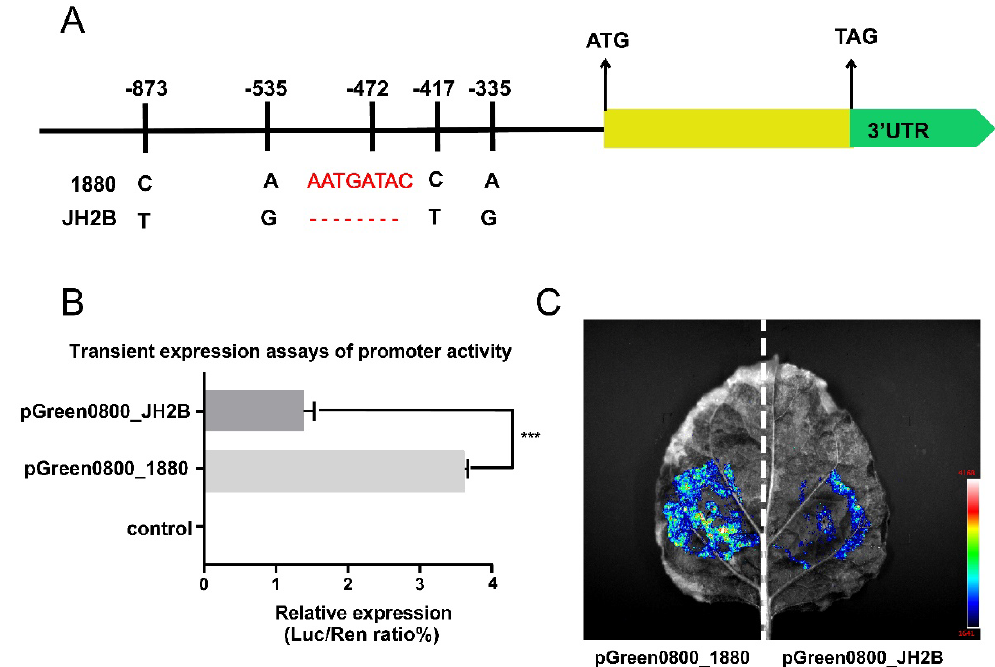
Figure 5. Sequence variations in the OsHd8 promoter. ( A ) Schematic representation of the two major variations of the OsHd8 promoter region. CT repeats are labeled in blue; red represents an InDel; ( B ) Transient expression assays of the two OsHd8 promoter types in rice protoplasts. Values are means ± SEM ( n = 6), *** indicates a significant difference at p < 0.001 by t-test; ( C ) Image of the Dual-LUC assay in tobacco leaves.